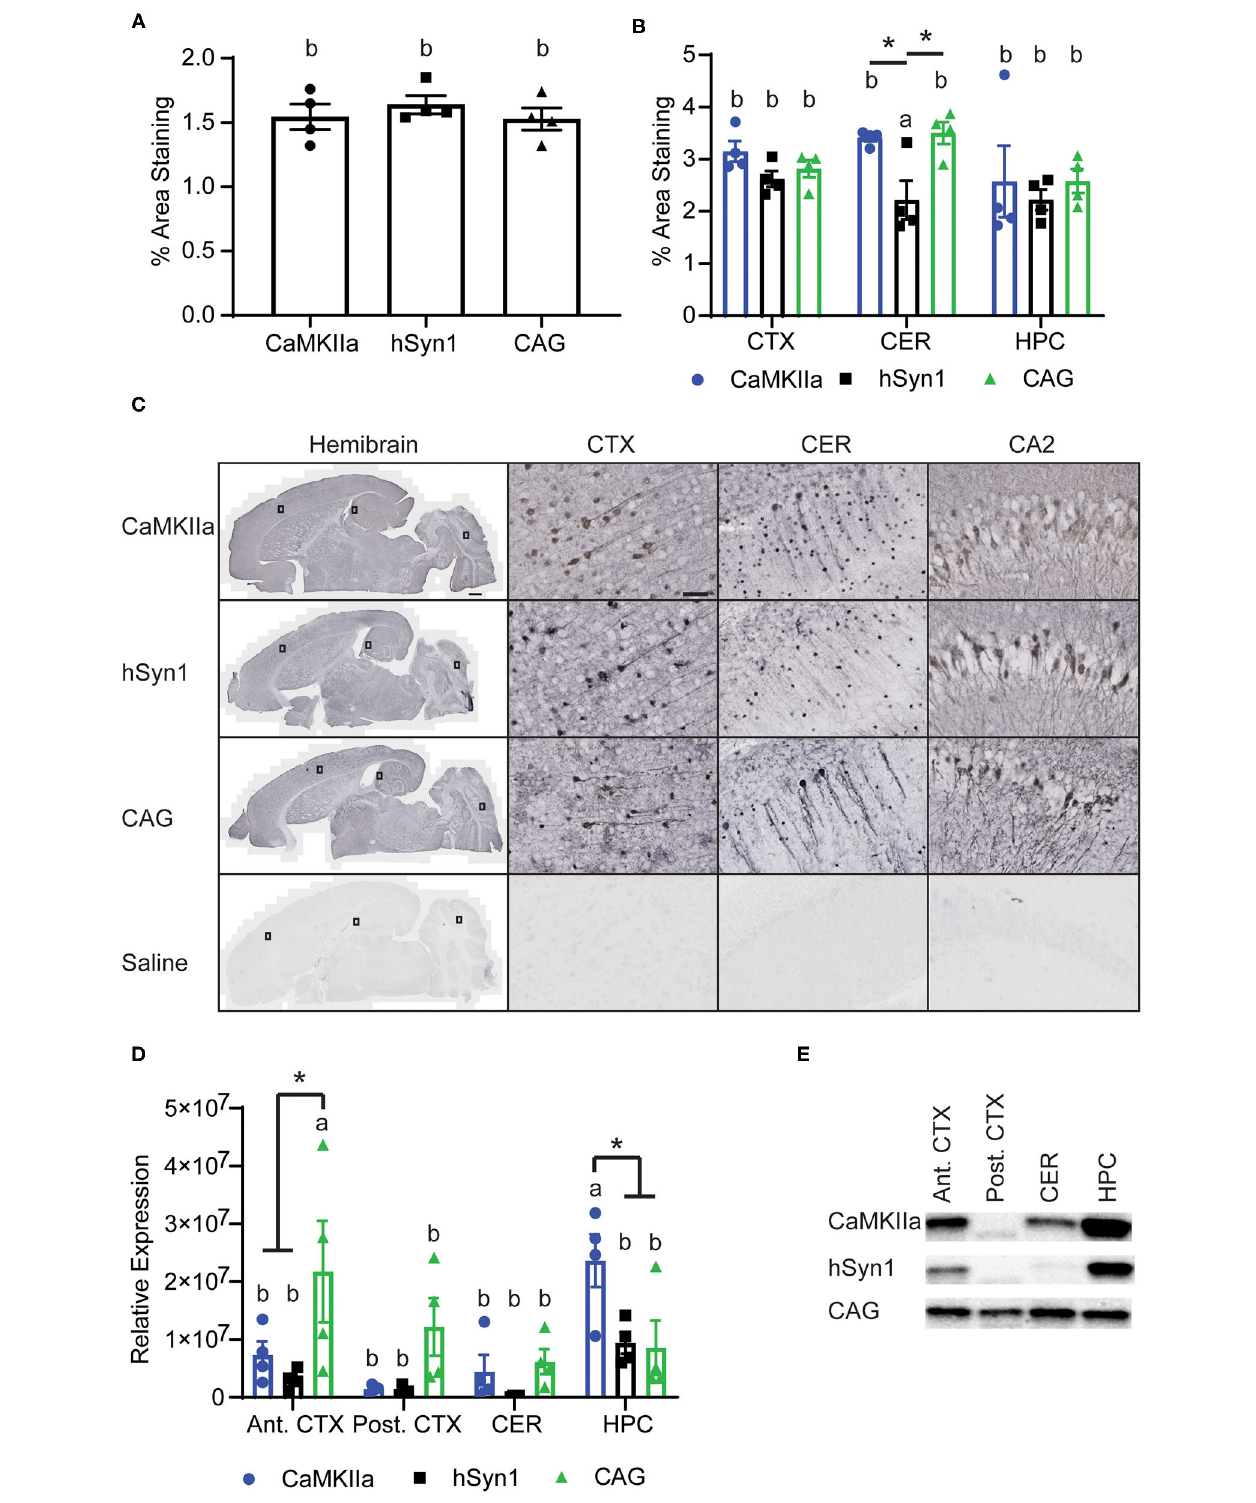
FIGURE 3 | CNS Expression of GFP protein. (A) Graph of percent area staining of GFP from hemibrain sections. (B) Graph of percent area staining of GFP in the cortex, cerebellum, and hippocampus. *denotes p < 0.05 by one-way ANOVA and Tukey’s post-hoc test. (C) Representative images of anti-GFP staining.